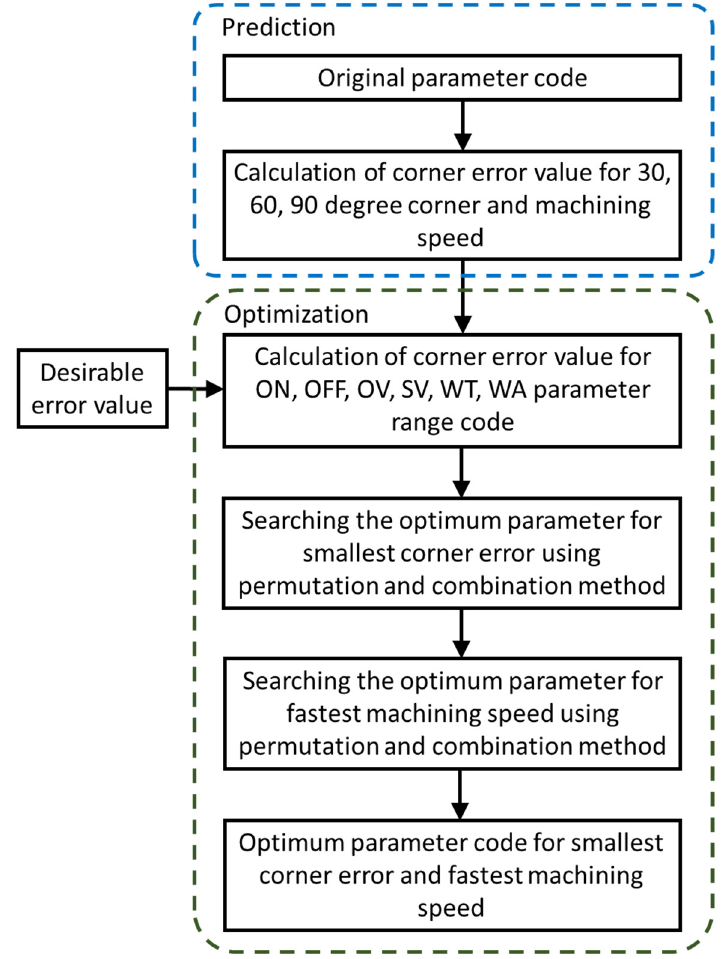
Figure 9. Algorithm of prediction and optimization for corner error and machining speed.